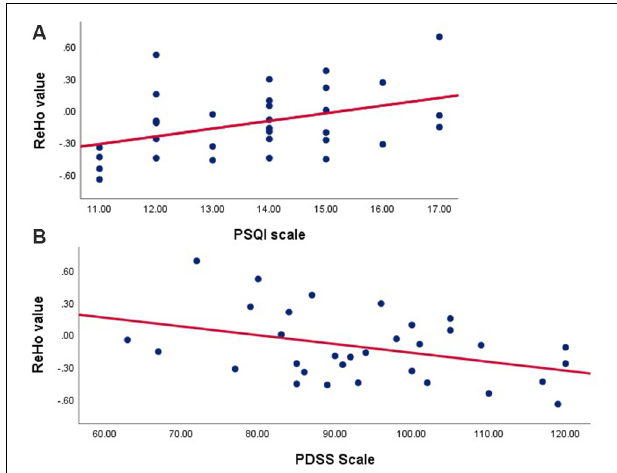
FIGURE 3 | Correlation analyses examining the associations between brain activity with clinical data in the TDPD-SD group. (A) Pearson’s correlation analysis between the ReHo value and the PSQI score in the TDPD-SD group; (B) Pearson’s correlation analysis between the ReHo value and the PDSS score in the TDPD-SD group. ReHo, regional homogeneity; PSQI, the Pittsburgh Sleep Quality Index; PDSS, Parkinson’s Disease Sleep